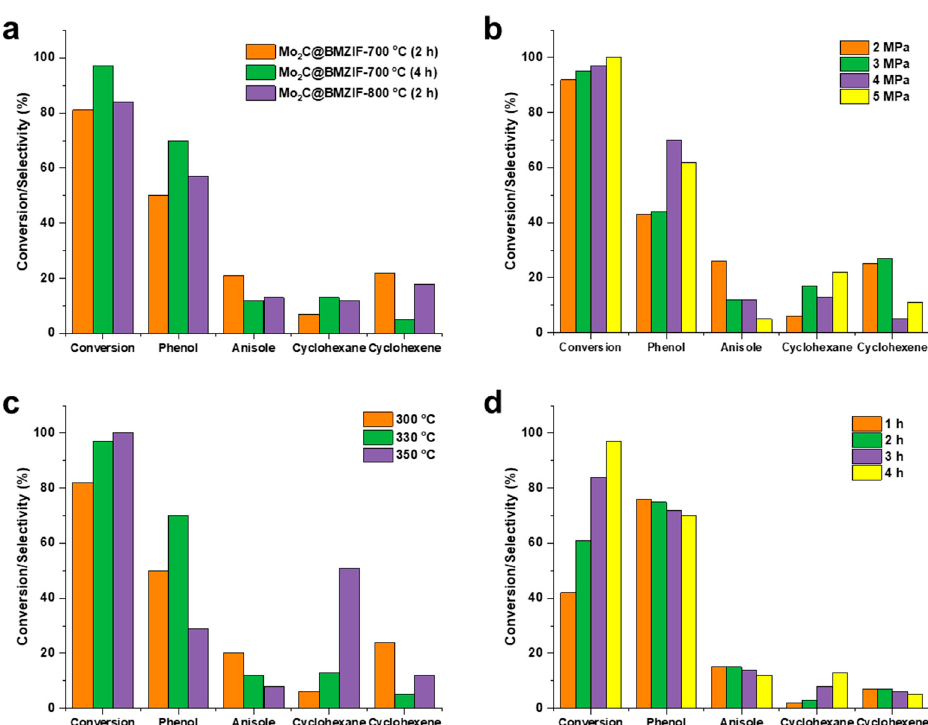
Figure 5. Conversion and product selectivity of catalytic HDO of guaiacol over Mo 2 C@BMZIF catalysts as a function of ( a ) carbonization condition of the catalyst, ( b ) reaction pressure, ( c ) temperature, and ( d ) time (a standard reaction condition: catalyst 60 mg, guaiacol 0.12 g, n -decane 20 mL, 330 °C, 4 h, 4 MPa). Mo 2 C@BMZIF-700 °C (4 h) catalyst was used for Figure 5b–d.